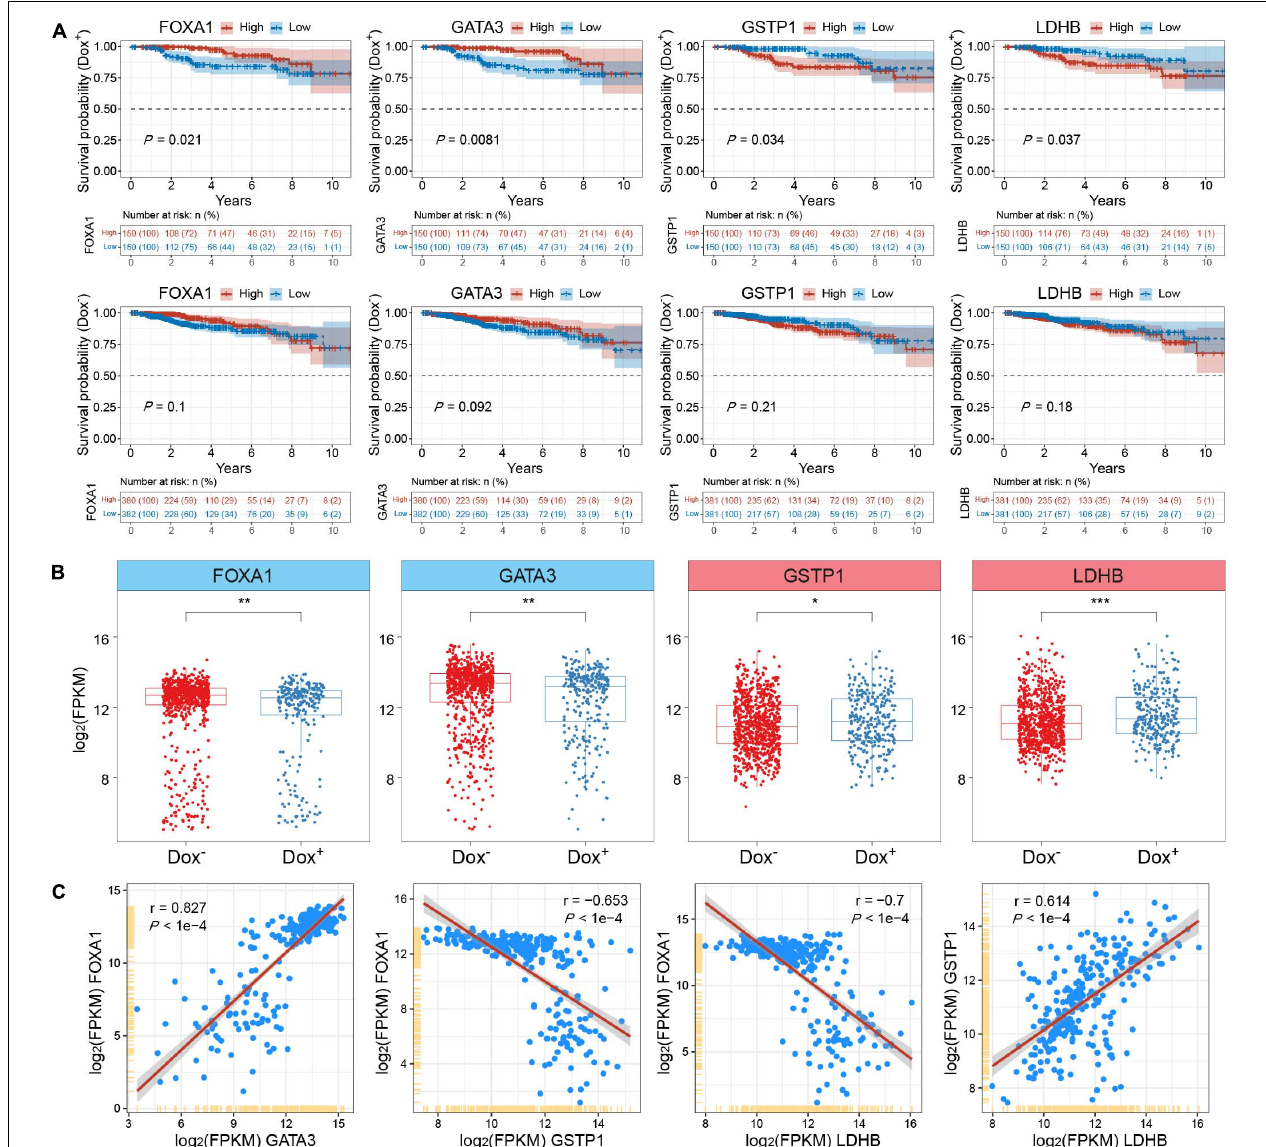
FIGURE 8 | Integrative analysis of clinical and genomic data from TCGA-BRCA datasets. (A) Kaplan–Meier survival analyses for FOXA1 , GATA3 , GSTP1 and LDHB of breast invasive carcinoma (BRCA) patients treated with (Dox + ; top panel) and without (Dox – ; bottom panel) doxorubicin (adriamycin). Expression values were sorted according to high and low expression (FPKM) from the median of the corresponding genes. The shaded area indicates the 95% confidence interval. All the survival duration was censored to 10 years. Statistical analysis was performed by the log-rank test, and P < 0.05 was statistically significant. (B) Box plots showing the mRNA expression levels (FPKM) of FOXA1 , GATA3 , GSTP1 and LDHB in Dox + and Dox – breast cancer subgroups derived from TCGA datasets. The P values were calculated by Wilcoxon’s signed-rank test. * P < 0.05, ** P < 0.01, and *** P < 0.001. (C) Correlation analysis of mRNA expression levels among FOXA1 , GATA3 , GSTP1 and LDHB in the Dox + breast cancer subgroup. The Pearson’s correlation coefficients (r) and P values were calculated using R packages. The shaded gray area around the red line represents the 95% confidence interval. The P value less than 0.05 was considered to be statistically